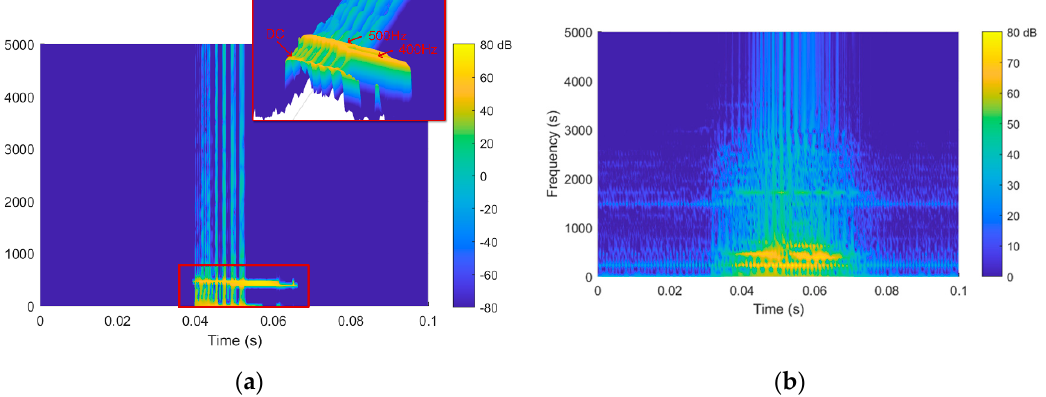
Figure 8. Time-frequency spectrogram of the measured common-mode disturbance on the battery charging cable represented by ( a ) joint TF and ( b ) WVD.